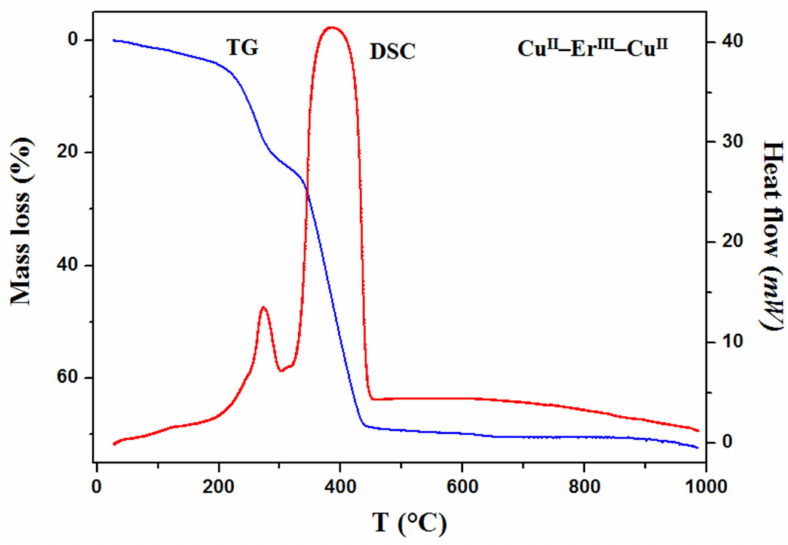
Figure 7. TG and DCS curves of thermal decomposition of the complex 2 in